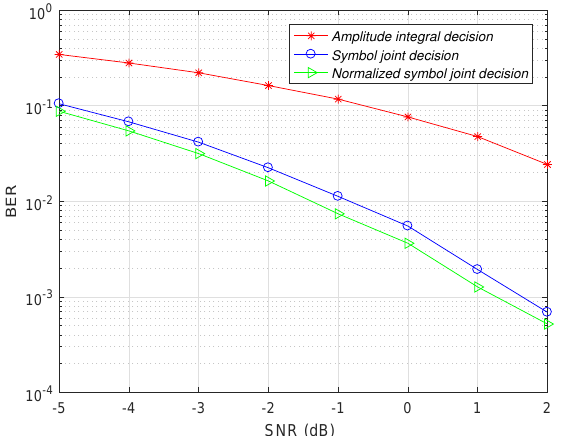
Figure 8. Bit error rate comparison of three decision